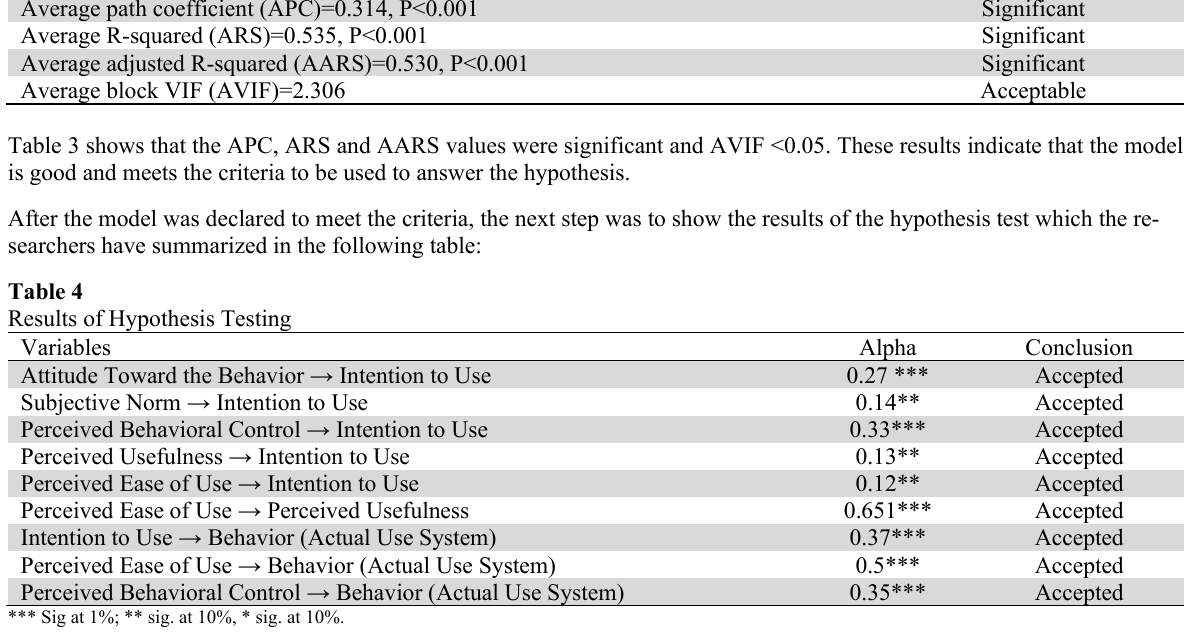
Model fit and quality indices Indicator Conclusion Average path coefficient (APC)=0.314, P<0.001 Significant Average R-squared (ARS)=0.535, P<0.001